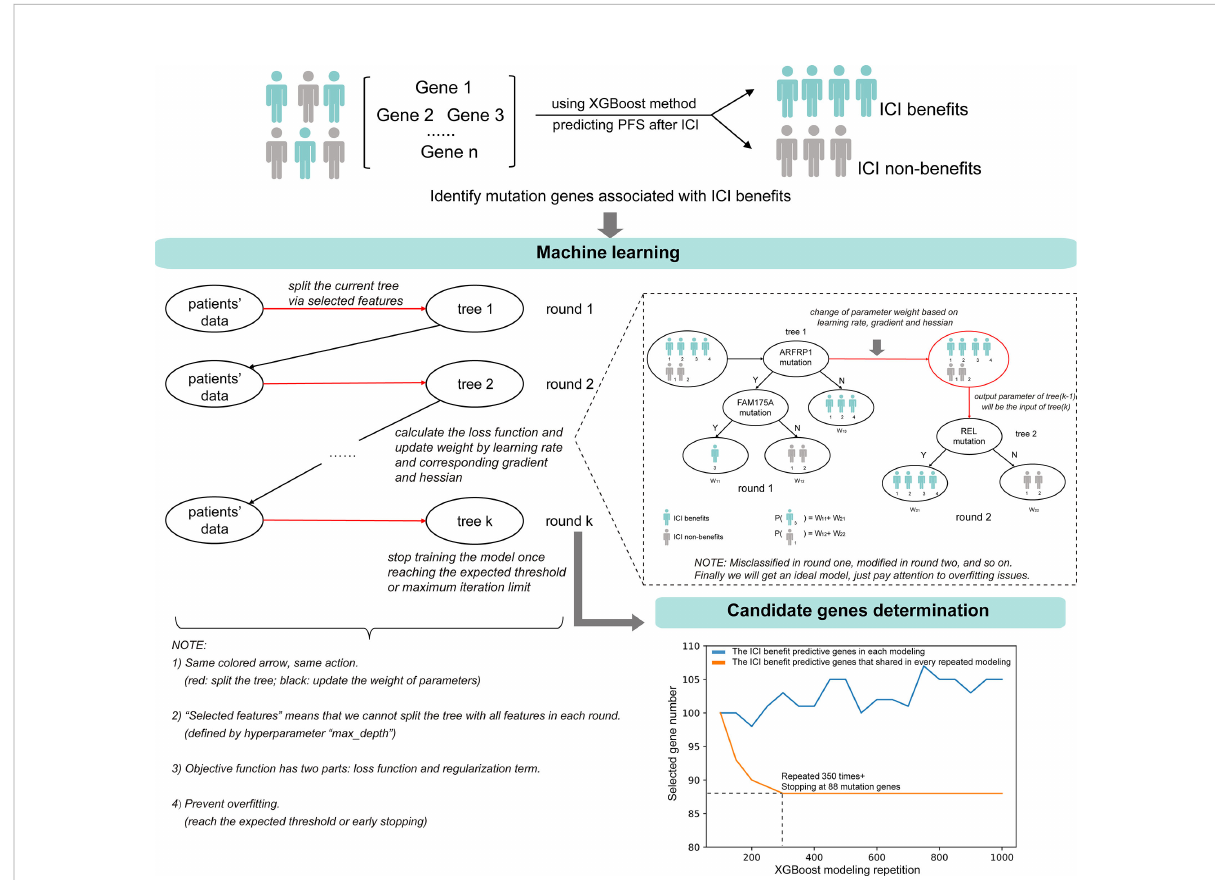
FIGURE 2 The identi fi cation of candidate mutation genes using XGBoost feature selection and the structural diagram of the machine learning